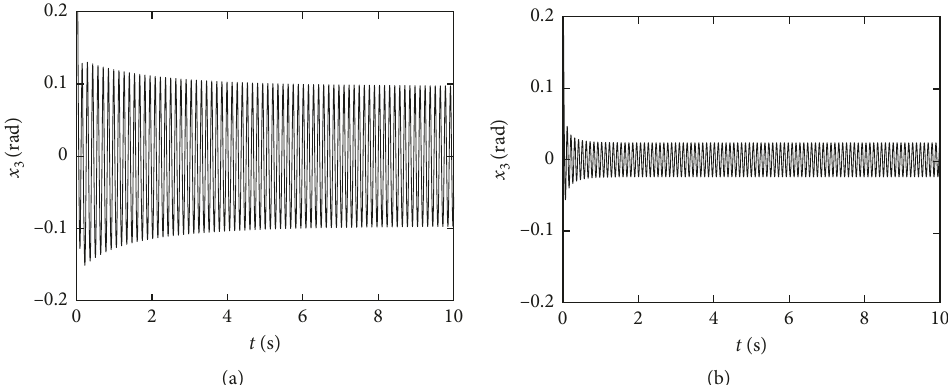
18 . 09 , k m 1 , and k n 0 . 01. (cid:31) (cid:31) (cid:31) −